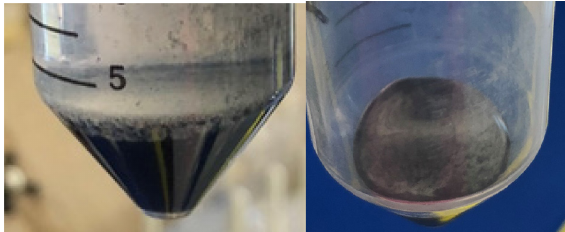
Fig. 2. White oxide layer formed on top of the sample (left) and resulting amount of oxide layer after removal (right). Some losses of carbon due to